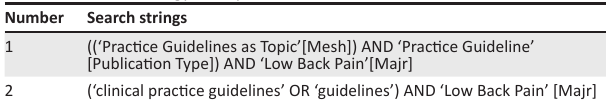
TABLE 1: Search strategy